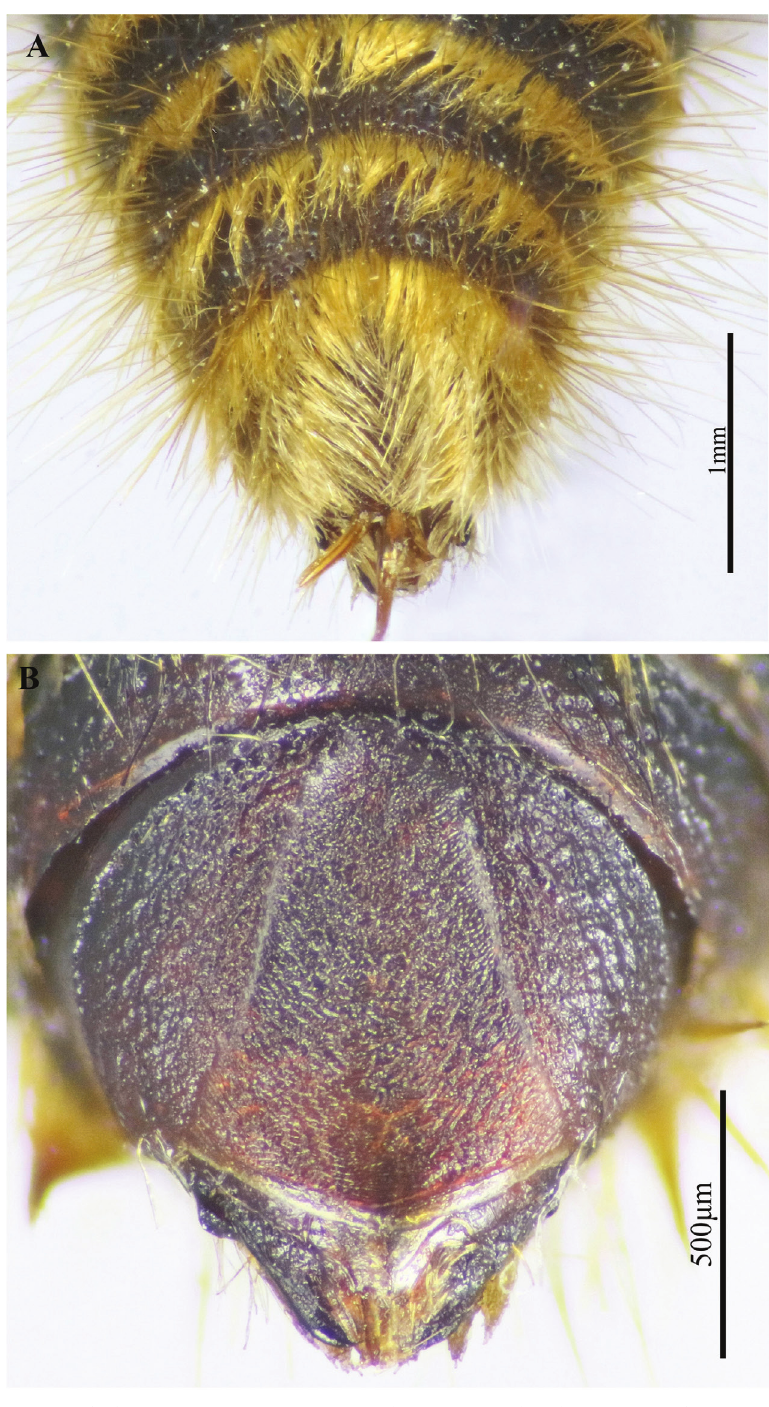
Figure 22. Pseudophotopsis mascatiana Invrea (Female) A T4–T6, dorsal view B T6 (after removing setae surrounding pygidial